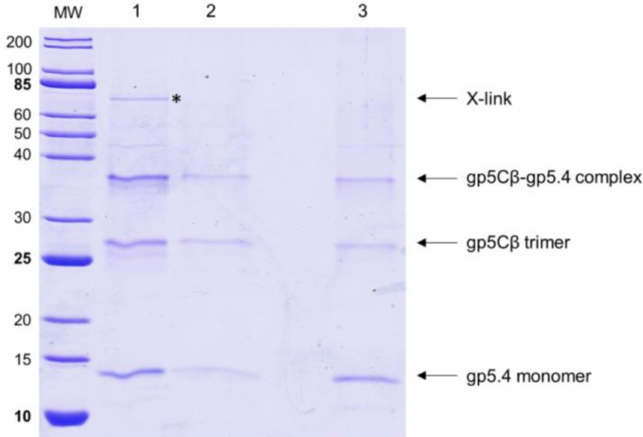
Figure 5. The gp5C β –gp5.4 complex interacts with spheroplast PpiD. The purified complex was incubated with spheroplasts in the presence of 0.5% formaldehyde for 10 min (Lanes 1 and 3). After a ffi nity purification, the complex coeluted with periplasmic protein PpiD, which was identified by matrix-assisted laser-desorption / -ionization (MALDI) analysis (Lane 1, asterisk). As control, the a ffi nity-purified gp5C β –gp5.4 complex is shown (Lane 2). To break the cross-link, sample was heated at 100 ◦ C (lane